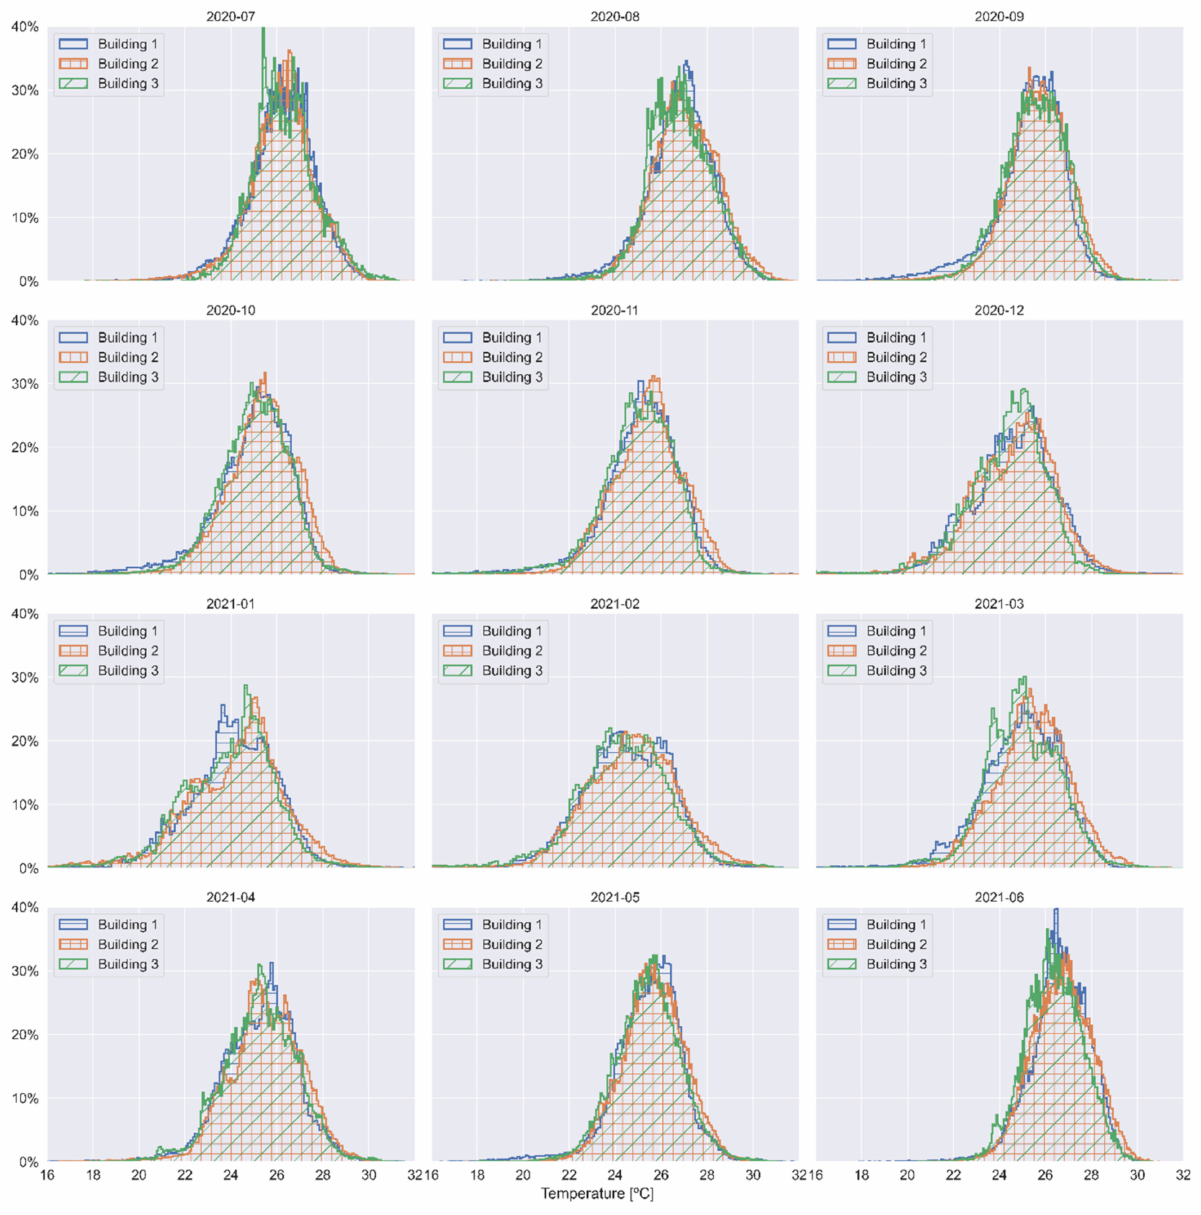
Figure 28. Probability density of hourly indoor temperature from all the apartments grouped by